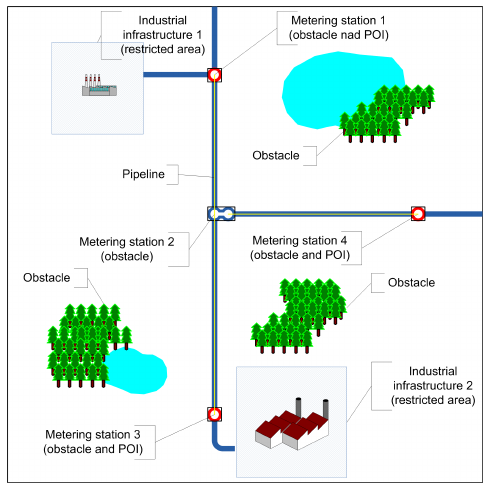
Figure 8. The workspace and the pipeline system under monitoring.